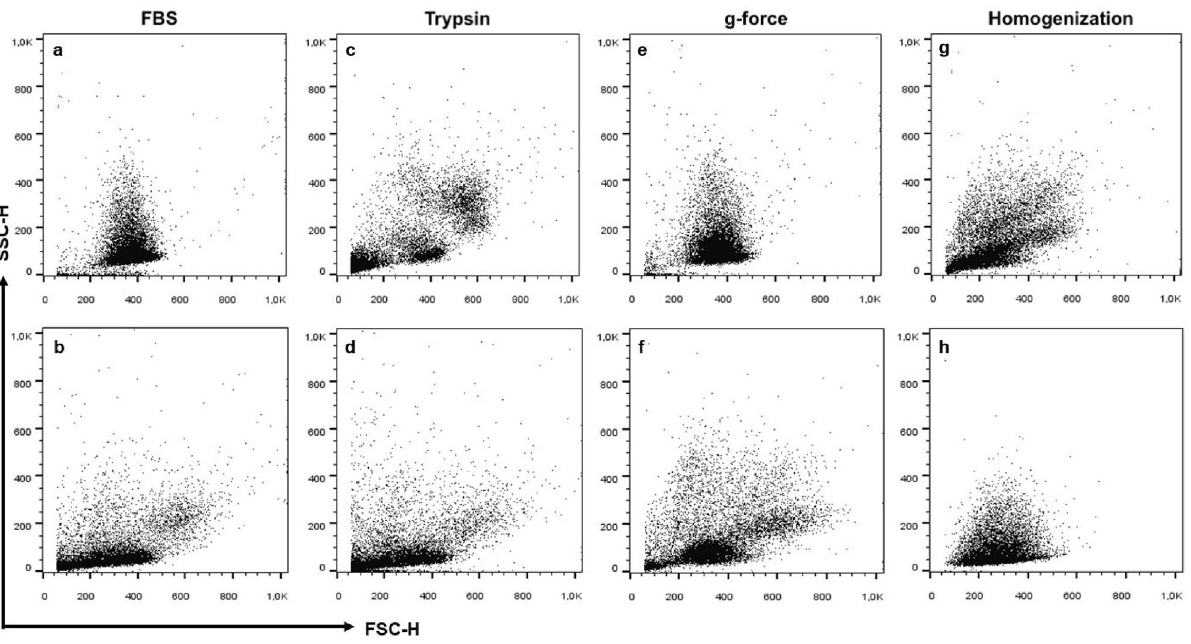
Figure 1. Comparison of cell isolation from PRF samples using different protocols for flow cytometry analysis. ( a ) Incubation with FBS; ( b ) without FBS; ( c ) incubation with trypsin; ( d ) without incubation with trypsin; ( e